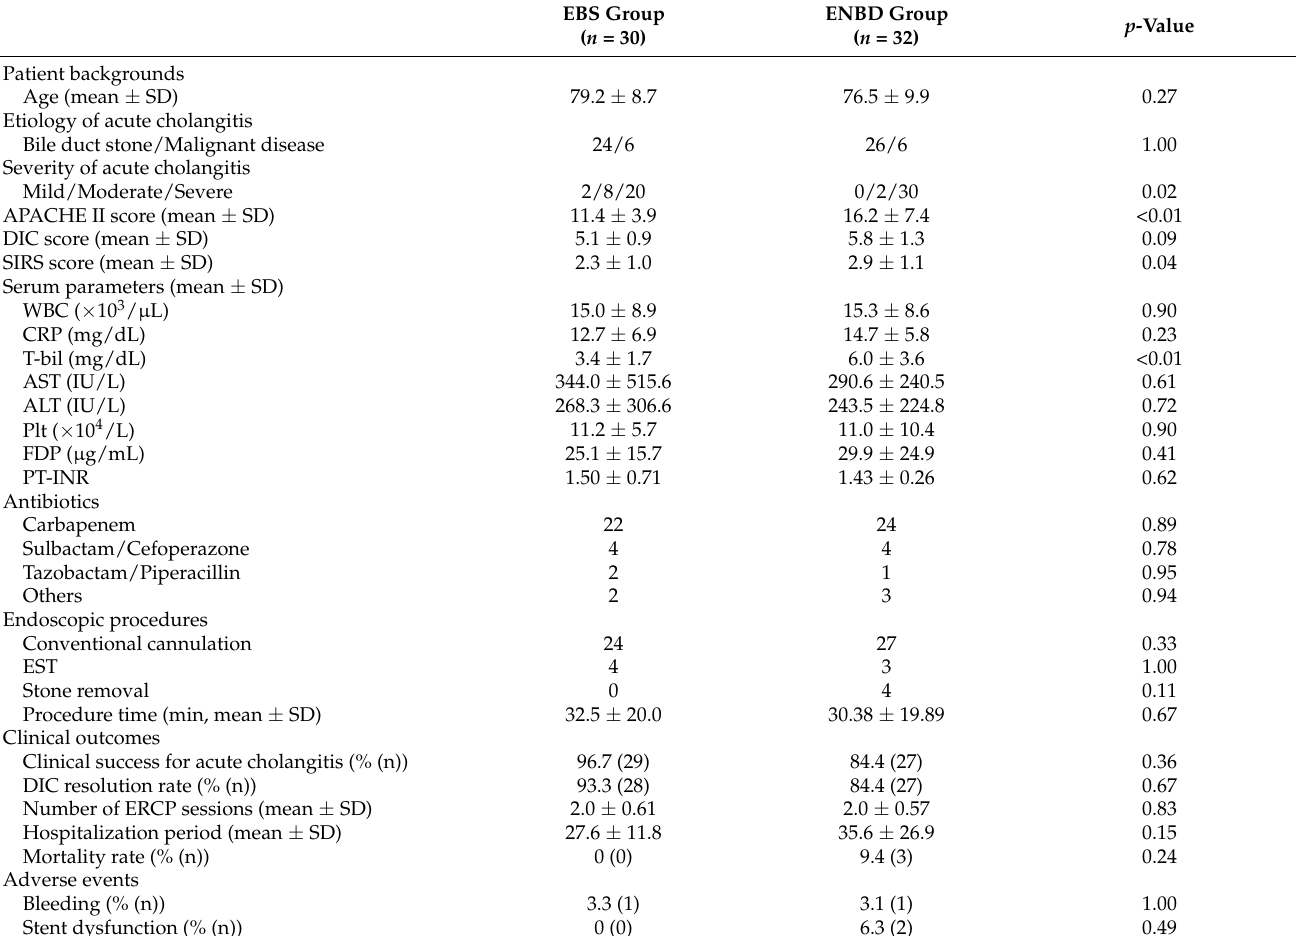
Table 6. Comparison between EBS and ENBD